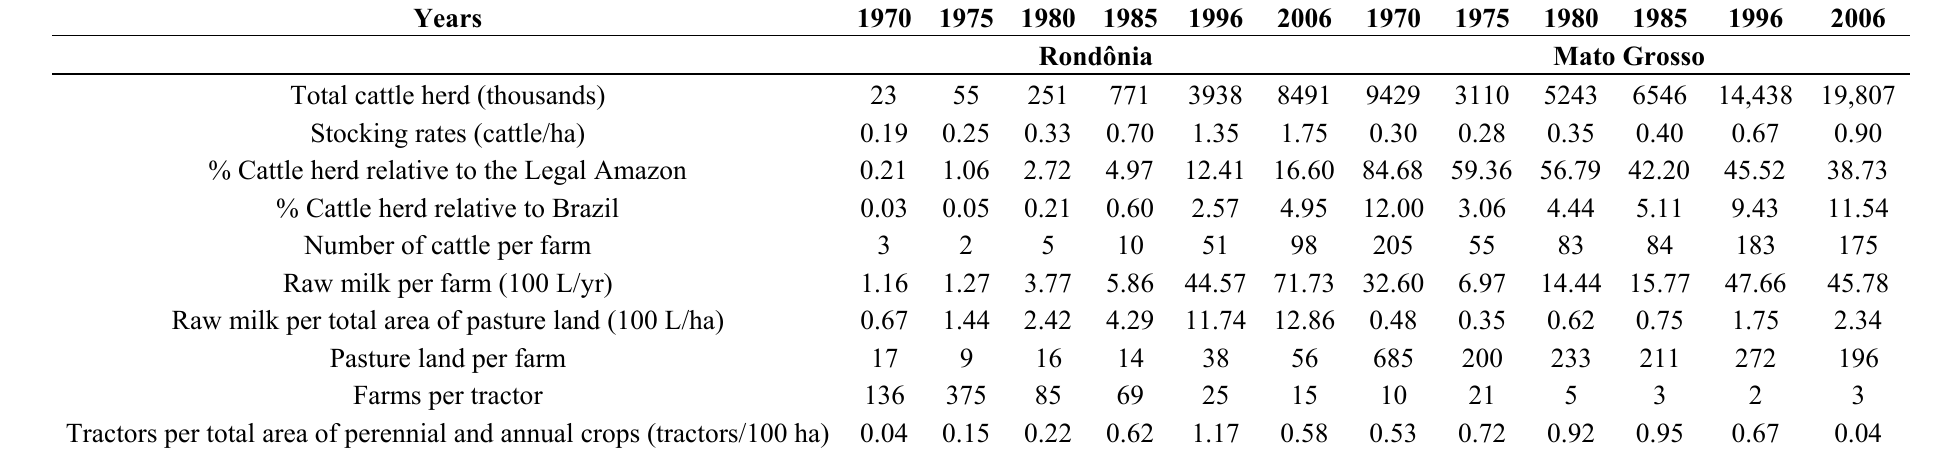
Table 2. Cattle herd, milk and tractor statistics in Mato Grosso and Rondônia based on census data from 1970, 1975, 1980, 1985, 1996, 2006.